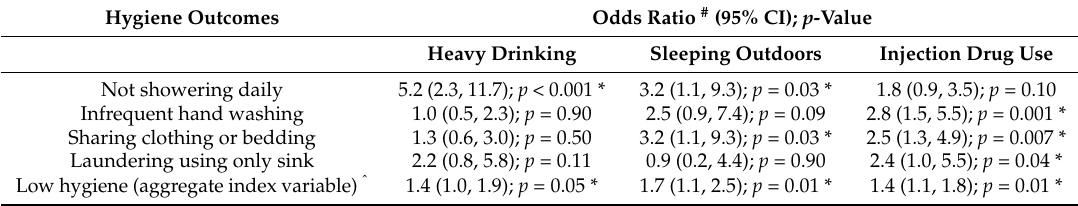
Table 2. Select risk factors for reduced hygiene behaviors among homeless persons in Boston, MA. Hygiene